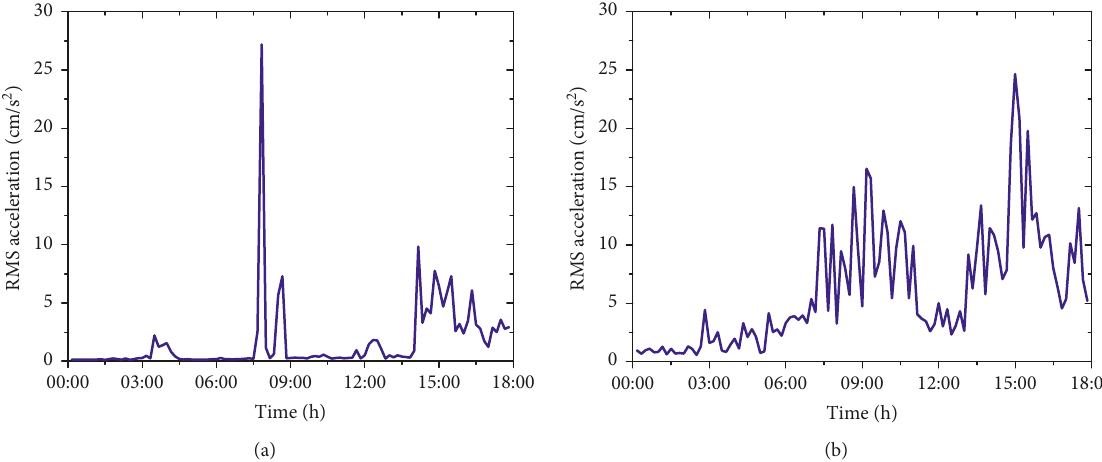
Figure 13: Time history of the 10min averaged RMS acceleration response. (a) Vertical RMS acceleration and (b) lateral RMS acceleration at the middle position of the main span.